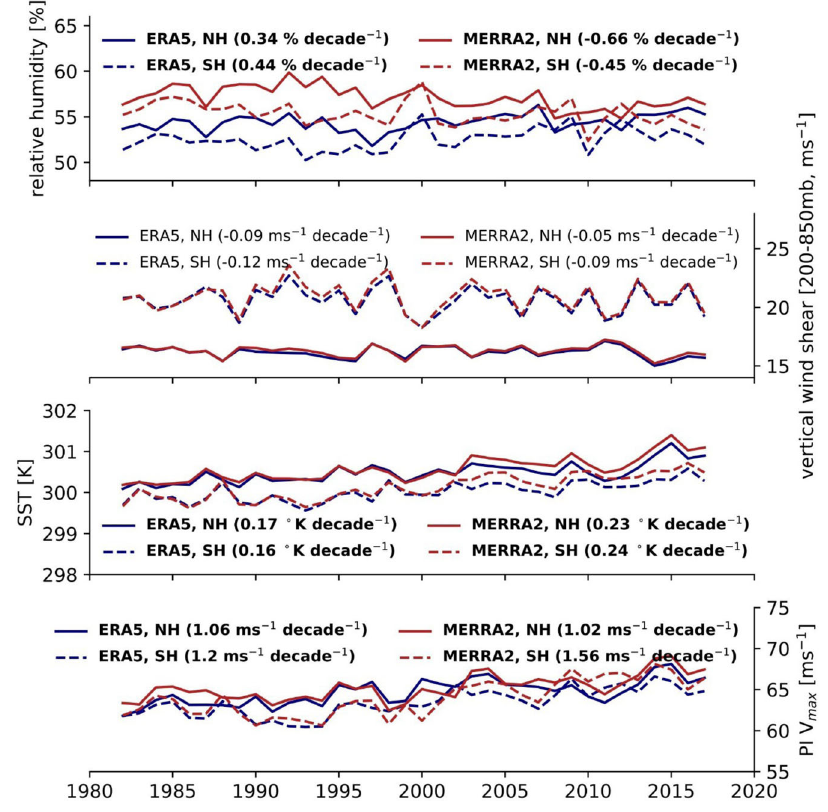
Fig. 5 | Trends in the favorability of tropical-mean environments. Observed trends in tropical-mean relative humidity (RH), vertical wind shear (SHR), sea sur- face temperature (SST), and potential intensity (PI Vmax) (top to bottom) in MERRA-2 (red) and ERA5 (blue) between 1982 – 2017. Dashed lines are used to